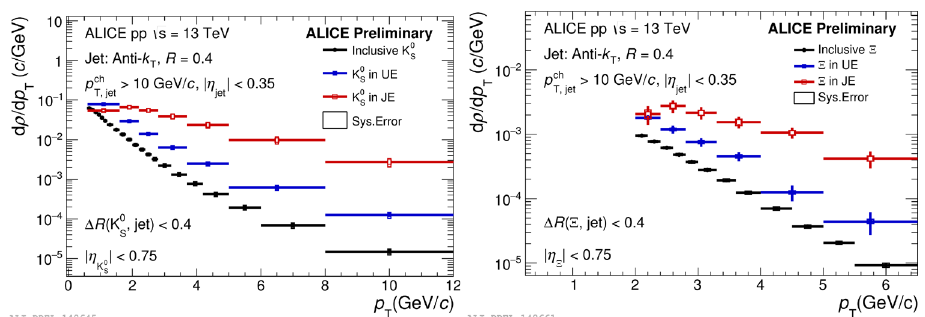
+ (left) and Ξ − + Ξ (right) in pp collisions at S